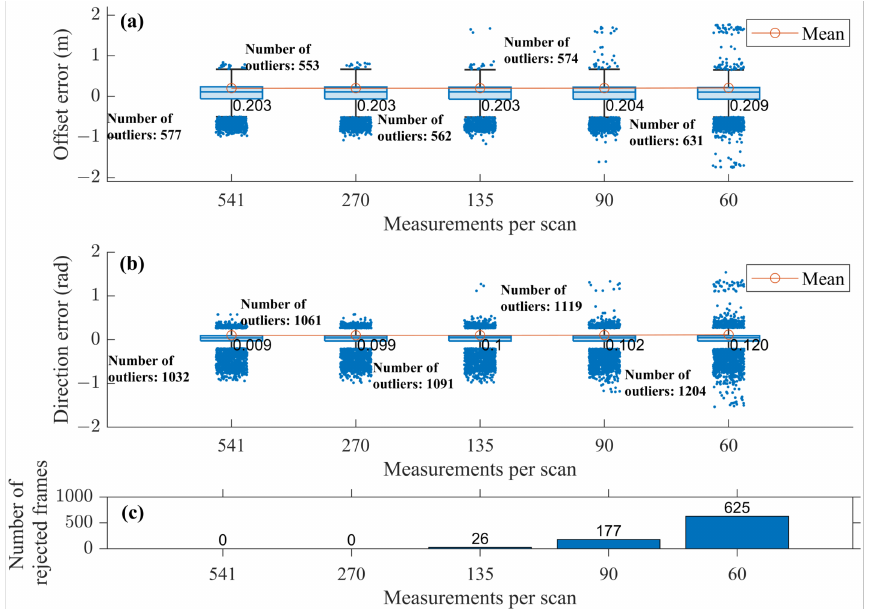
Figure 13. Result from dataset 1 with different data rates: ( a ) offset error; ( b ) direction error; ( c ) number of rejected frames.